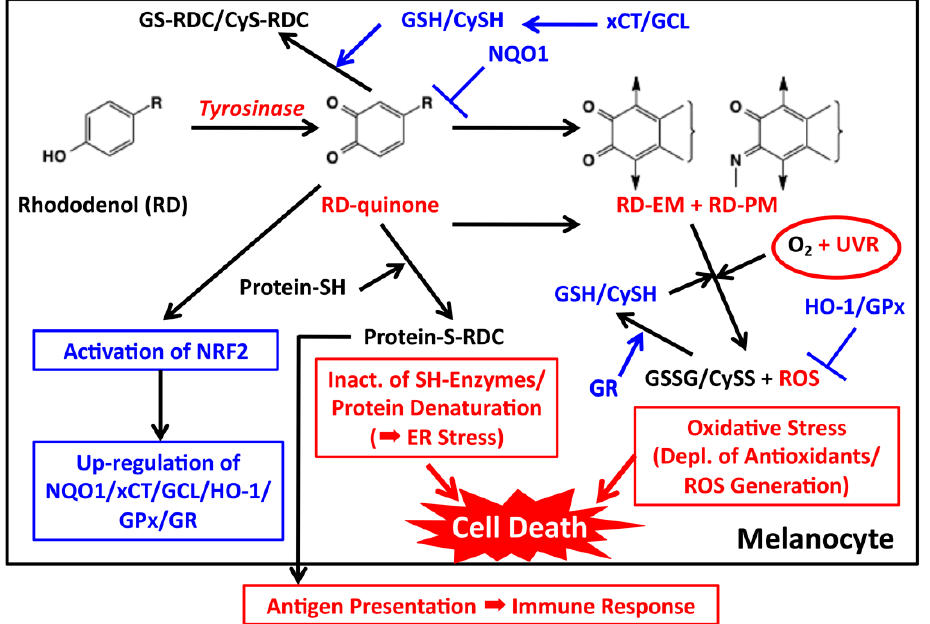
Figure 5. Proposed biochemical mechanism of RD-induced leukoderma. Toxic events are shown in red while detoxifying events are shown in blue. Tyrosinase catalyzes the oxidation of RD to form two toxic metabolites, RD-quinone and RD-melanin. RD-quinone reacts with CySH and GSH to give the adducts, CyS-RD-catechol (CyS-RDC) and GS-RD-catechol (GS-RDC). RD-quinone also reacts with protein-SH to give the protein adduct, protein- S -RD-catechol (protein- S -RDC). This reaction leads to